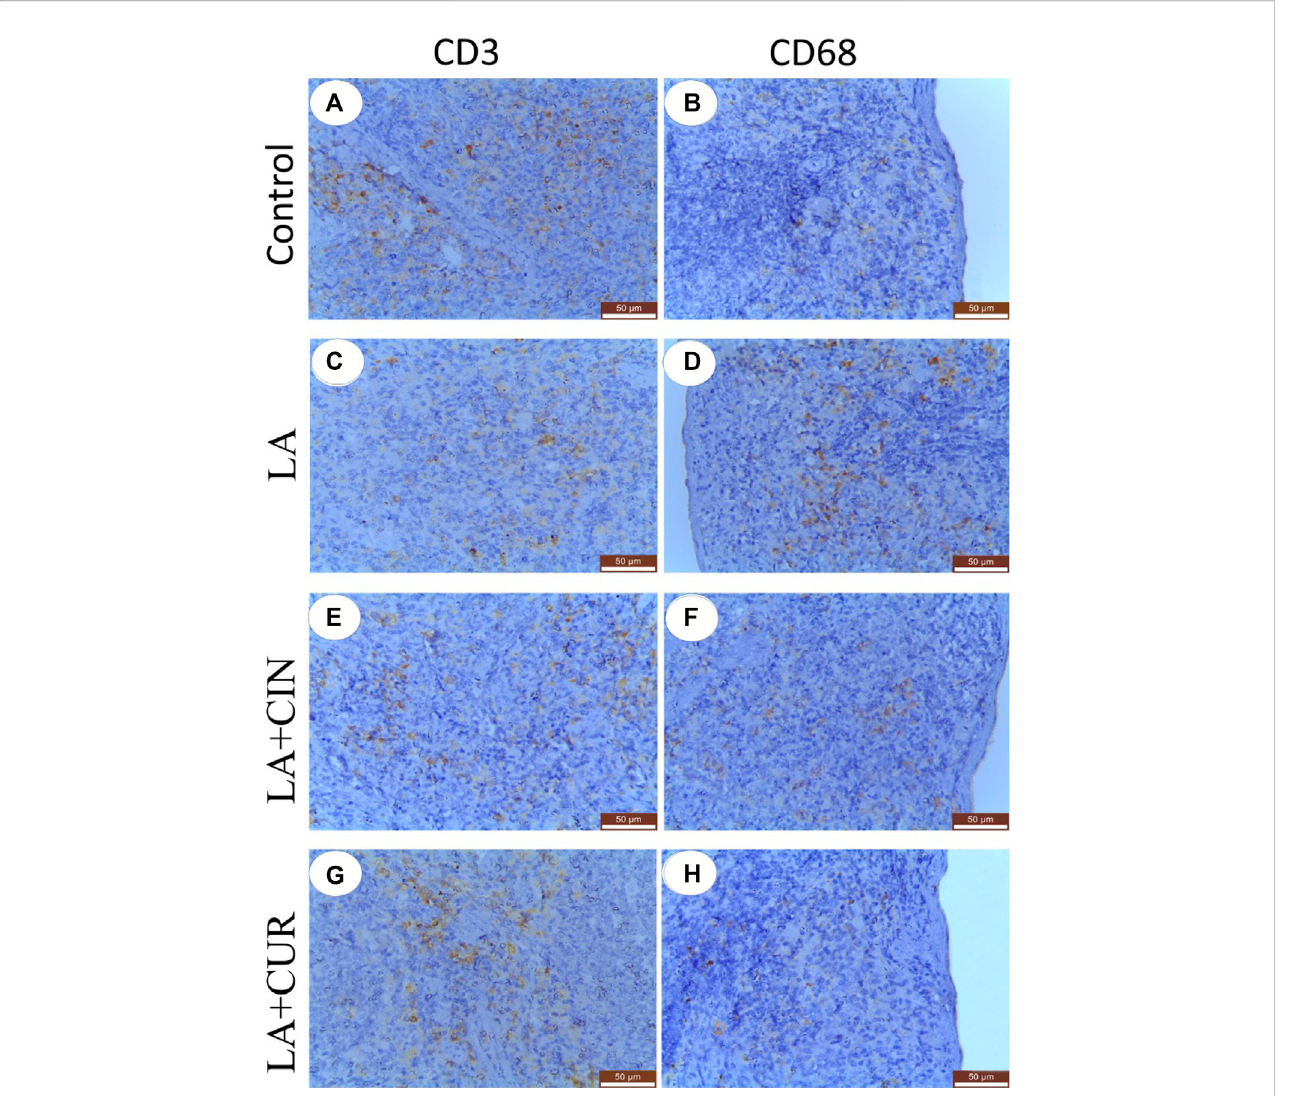
FIGURE 9 Immunohistochemically stained sections of the spleen with CD3 (A,C,E, and G) and CD68 (B,D,F, and, H) from different groups. (A) control group showed strong CD3 immunostaining, (C) LA group showed weak CD3 immunostaining, e and g ; LA + CIN, and LA + CUR groups showed moderate CD3 immunostaining, (B) and (H) ; controlandLA+CURgroupsshowedweakCD68, (D) ;LAgroupshowedstrongCD68immunostaining,and (F)